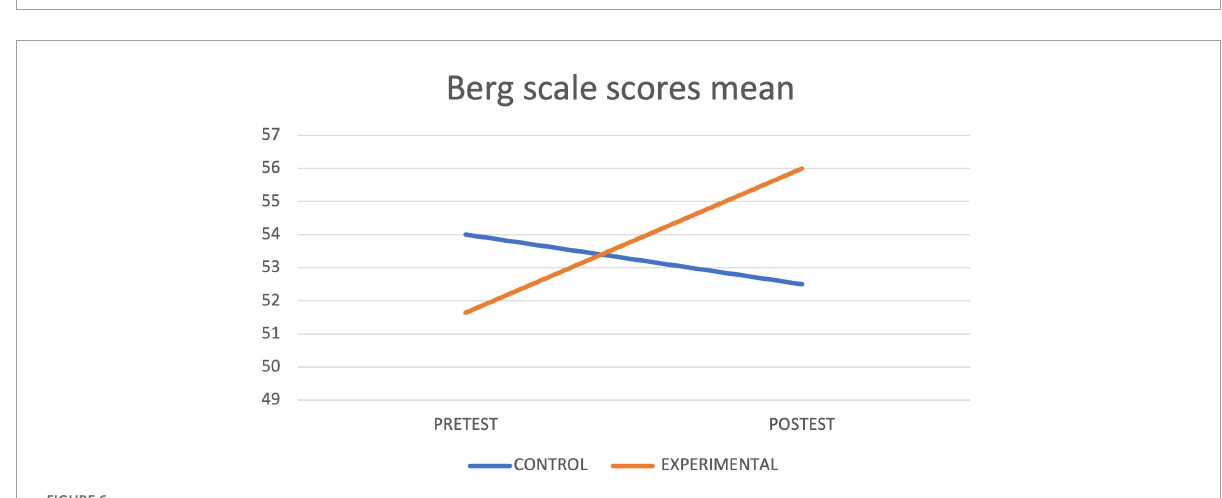
FIGURE6 Best lineal